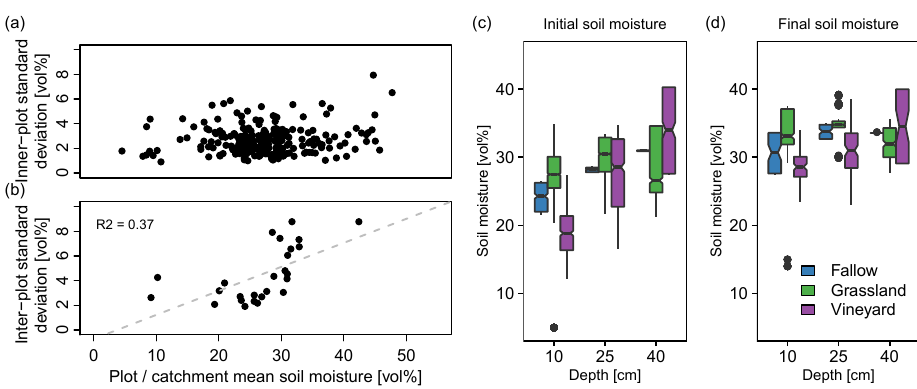
(t ev ) , as calculated with Eqs. (1) j